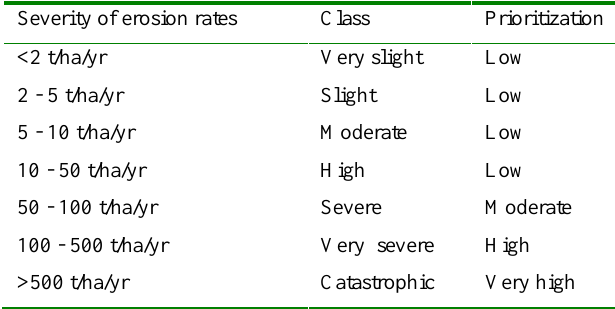
Table 6. Prioritization of areas for sustainable urban